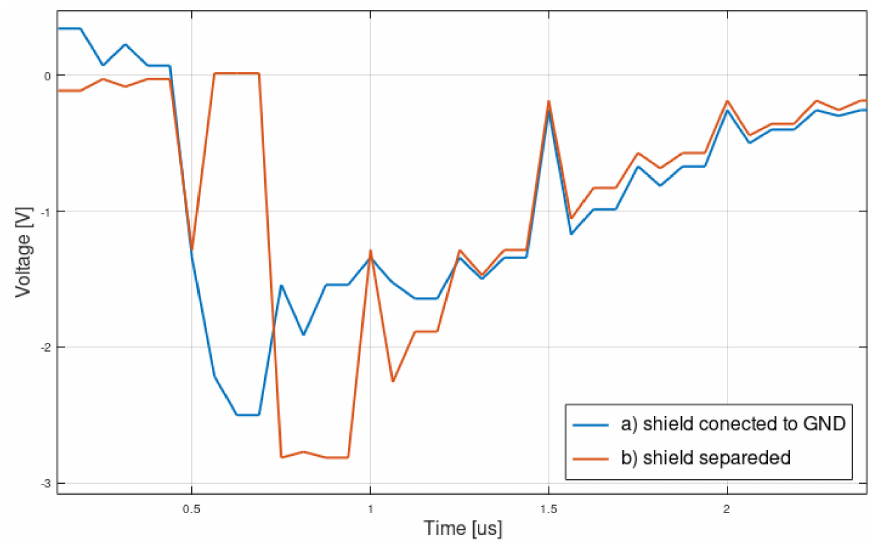
Figure 10. Difference between cover connected and not connected to the ground